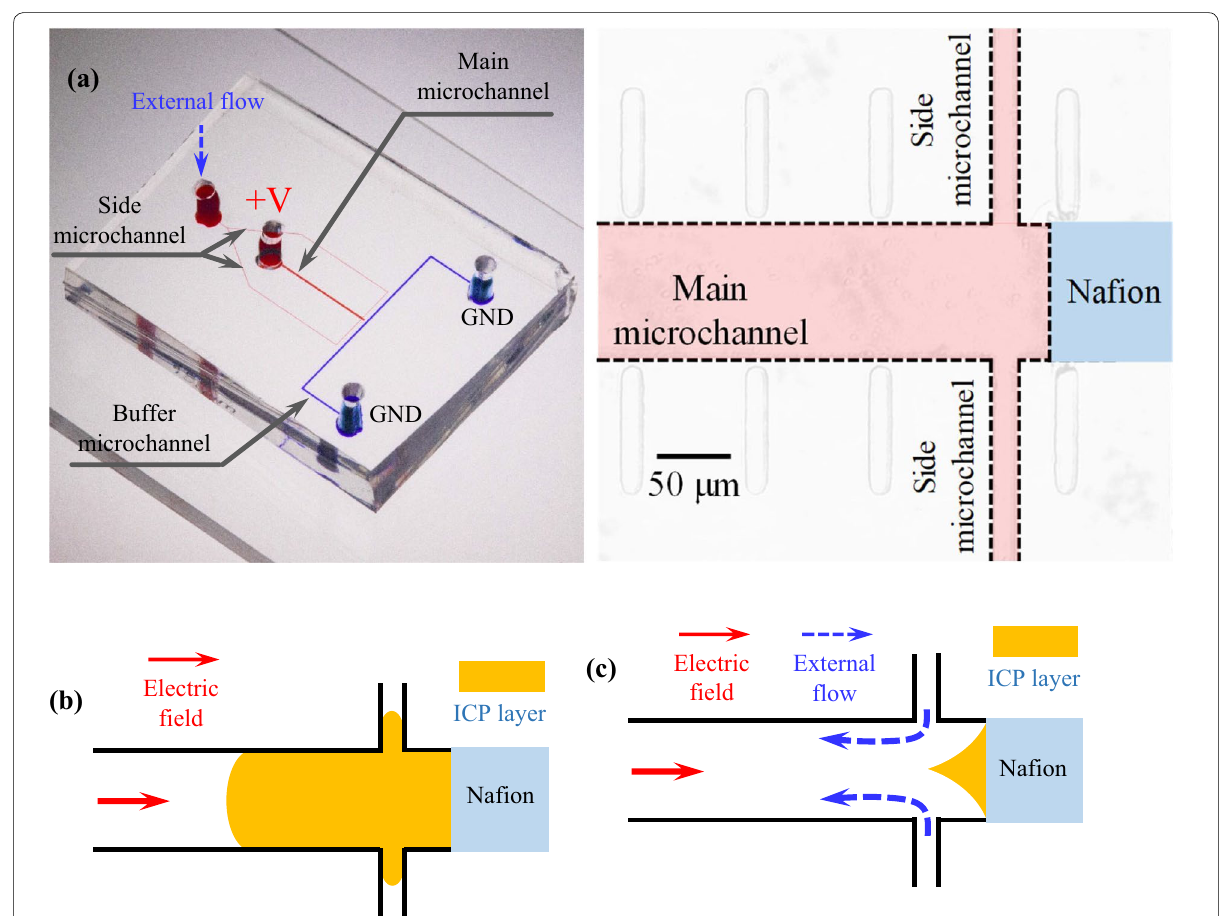
Fig. 1 a Image of micro/nanofluidic device used in this work and the magnified view of the device. Main and buffer microchannel had the dimension of 15 μm depth 100 μm width and the side microchannel had one of 15 μm depth × external flow from two side